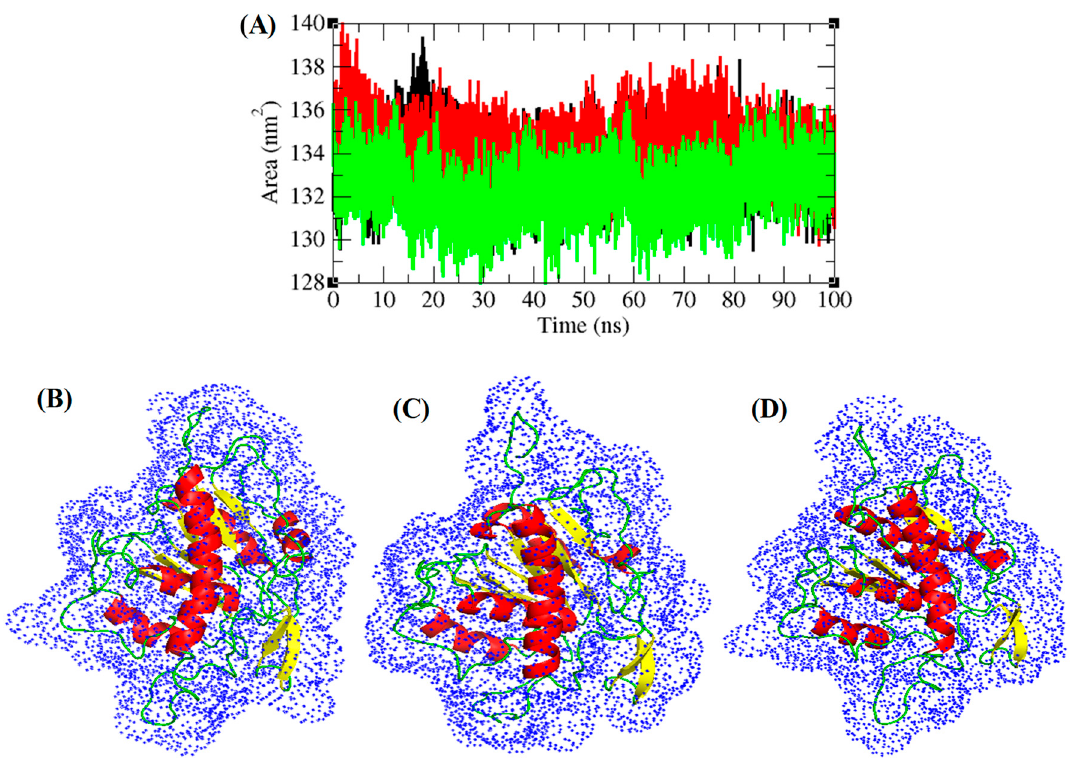
Figure 7. SASA (Solvent Accessible Surface Area) of TmPLB1. ( A ) SASA of TmPLB1 were represent in cartoon model ( B ) 30 °C, ( C ) 35 °C, and ( D ) 40 °C, respectively. Black, red, and green colors were depicted the 30 °C, 35 °C, and 40 °C, respectively.